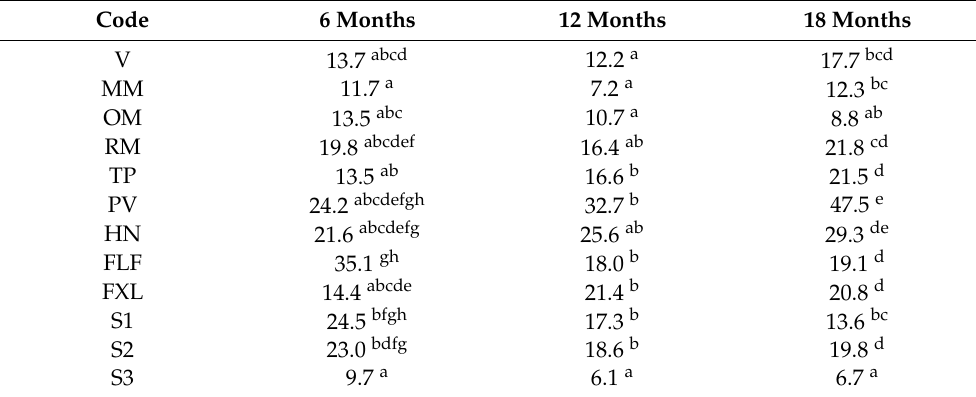
significantly different at the p < 0.05